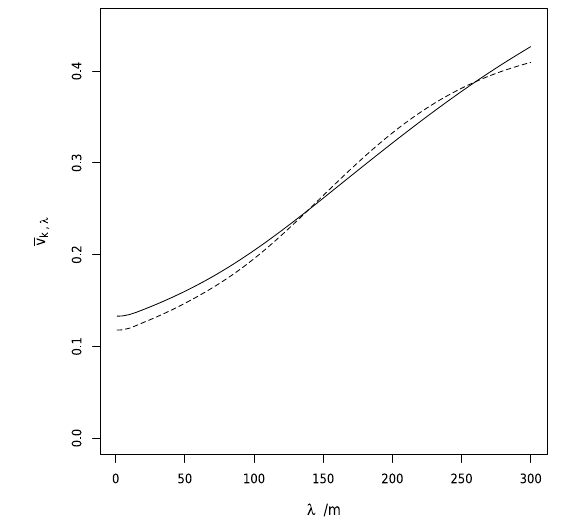
Figure 4. Estimates of b F ( v t | λ, ) (Eq. 9) for different grid spacings with v t set to 0.18. The dotted line shows the grid spacing (44.2m) at which b F ( v t | λ, ) = 0 . 8.